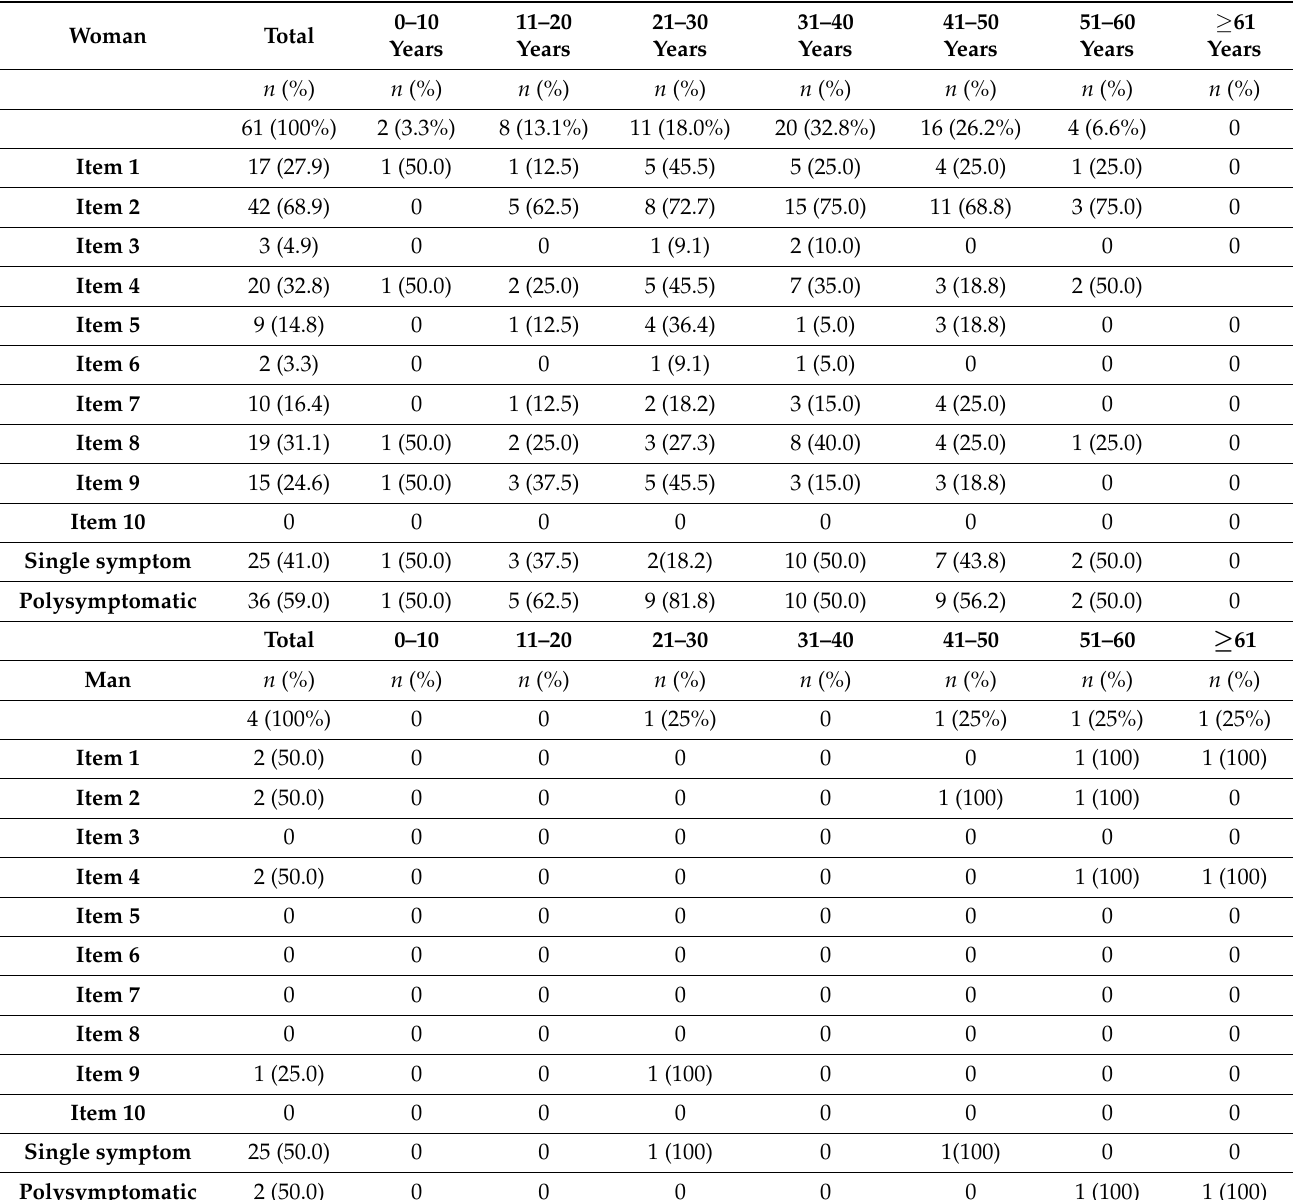
Table 5. Frequency of cases, appearance of the first symptoms related to MCS by age groups and sex. Scale 3 of the QEESI